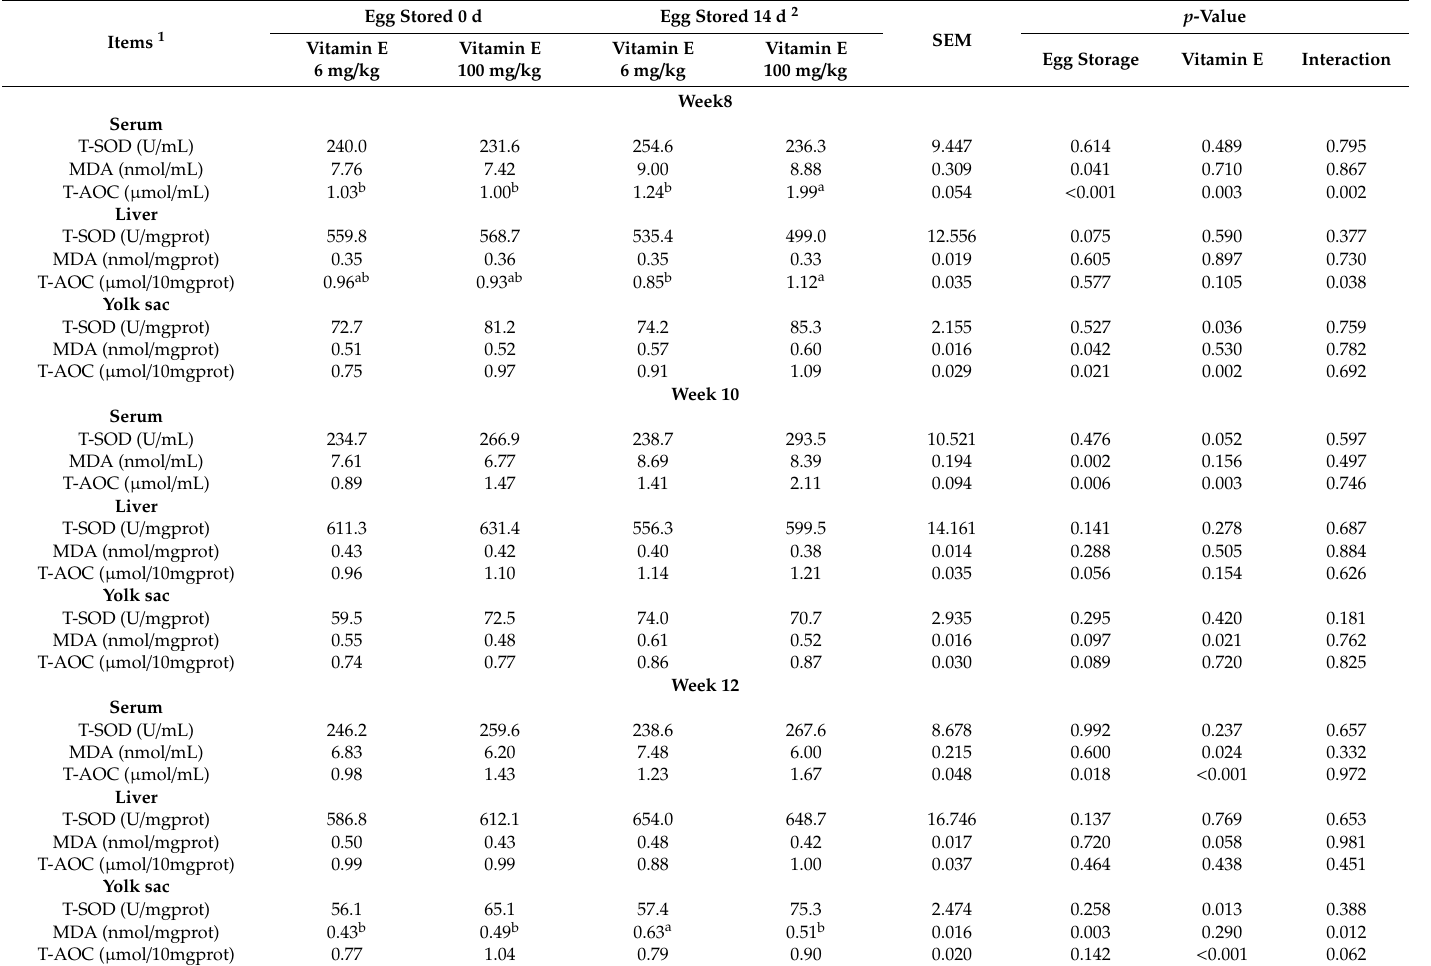
Table 5. The e ff ects of broiler breeder dietary vitamin E and egg storage time on the antioxidant status of newly hatched